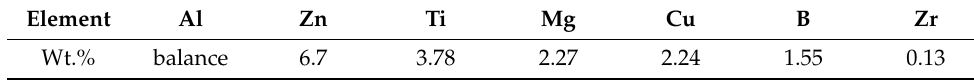
Table 2. TiB 2 /7050 aluminum matrix composite